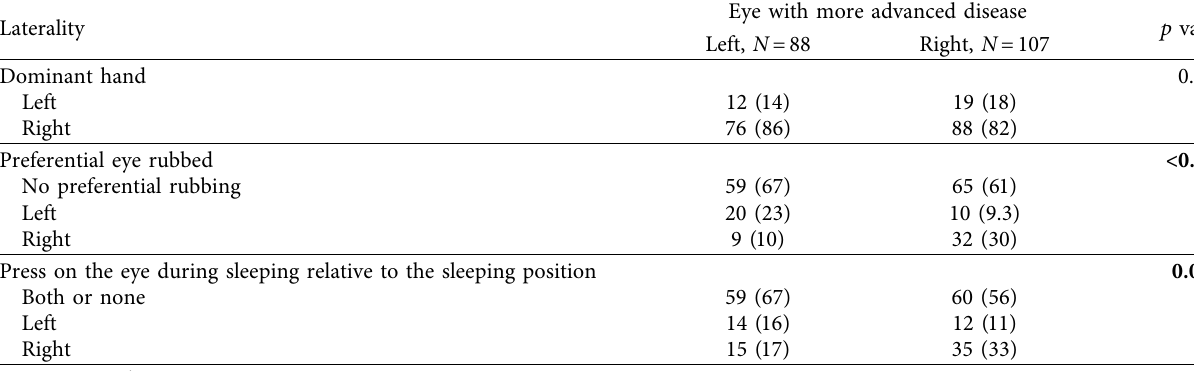
Table 5: Analysis of eye for more advanced